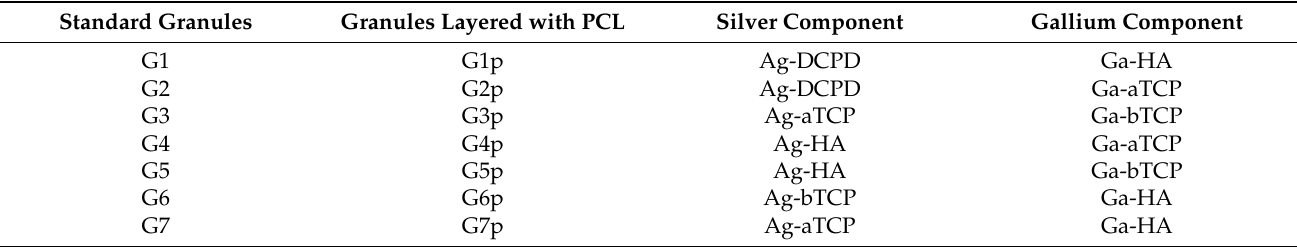
Figure 1. Scheme of composite granules preparation (CS—chondroitin sulfate, SA—sodium alginate, CaPs—different calcium phosphates). Table 2. List of granules prepared of previously obtained CaP powders .